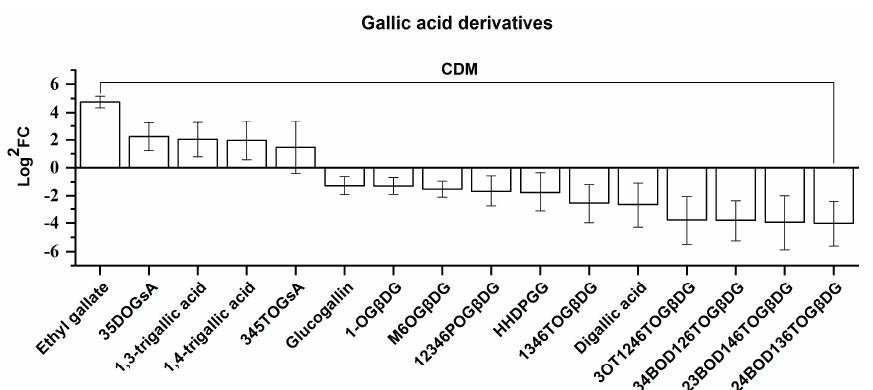
Figure 10. Comparison of gallic acid derivatives, consisting of 16 CDMs between SJL and SN. These 16 CDMs were further divided into 5 upregulated and 11 downregulated CDMs. Upregulation denotes that the content of a metabolite increased in SN compared with that in SJL, and the opposite for downregulation. The Y -axis is exhibited as Log 2 FC values for the convenience of visual presentation (note that the up and down amplitudes in the text refer to the FC value). The X -axis denotes the metabolite names. Abbreviation: 35DOGsA, 3,5-di- O -galloylshikimic acid; 345TOGsA, 3,4,5-tri- O -galloylshikimic acid; 1-OG β DG, 1- O -galloyl-beta- D -glucose; M6OG β DG, methyl 6- O - galloyl- β - D -glucopyranoside; 12346POG β DG, 1,2,3,4,6-penta- O -galloyl-beta- D -glucose; HHDPGG, HHDP-galloylglucose; 1346TOG β DG, 1,3,4,6-tetra- O -galloyl-beta- D -glucose; 3OT1246TOG β DG, 3- O - trigalloyl-1,2,4,6-tetra- O -galloyl-beta- D -glucose; 34BOD126TOG β DG, 3,4-bis- O -digalloyl-1,2,6-tri- O - galloyl-beta- D -glucose; 23BOD146TOG β DG, 2,3-bis- O -digalloyl-1,4,6-tri- O -galloyl-beta- D -glucose; 24BOD136TOG β DG, 2,4-bis- O -digalloyl-1,3,6-tri- O -galloyl-beta- D -glucose.